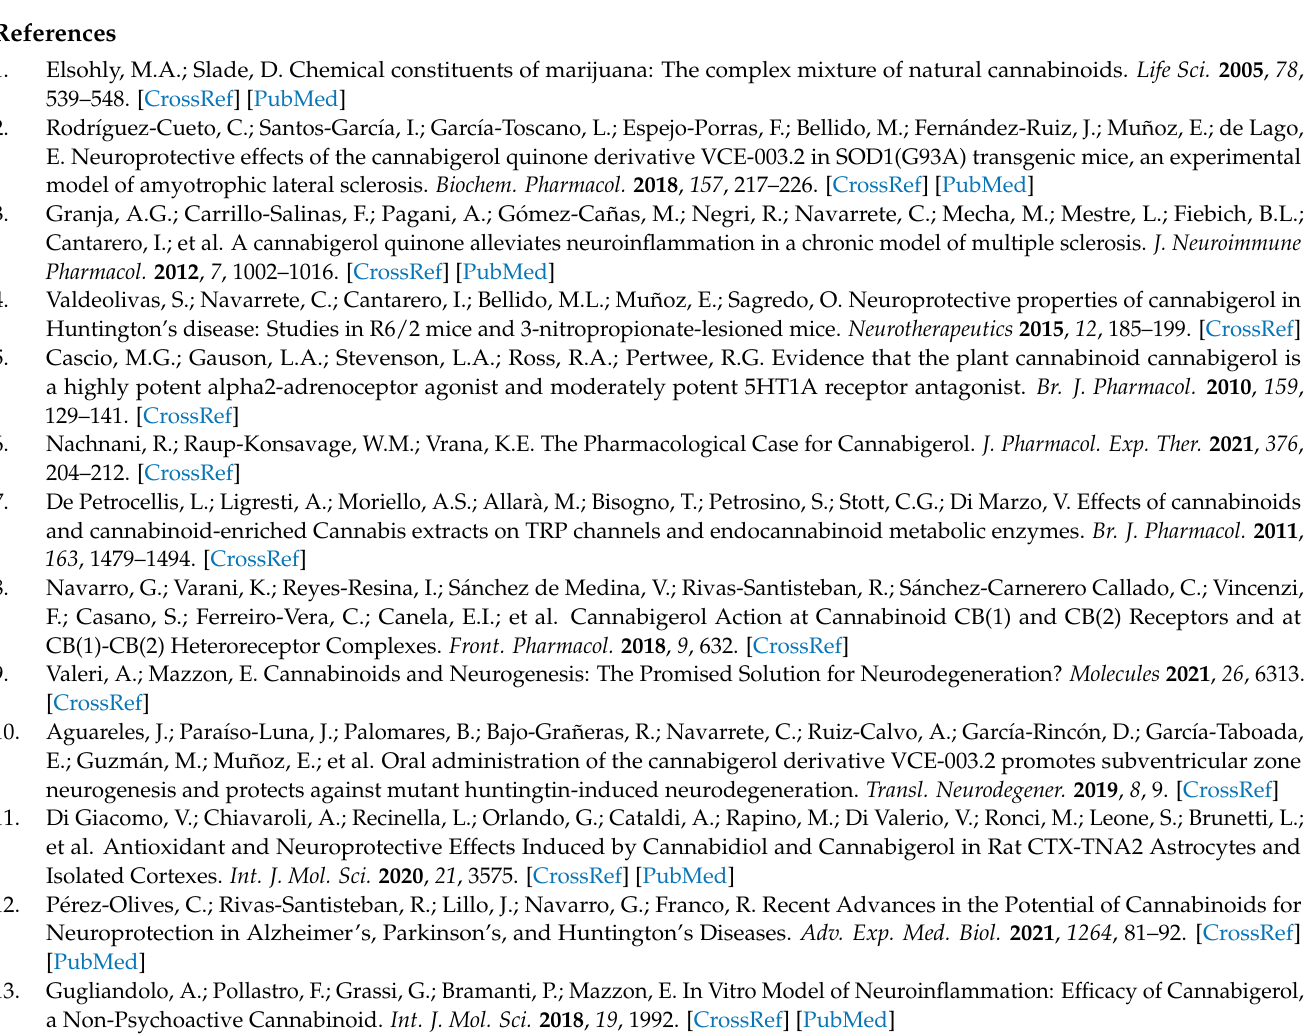
Figure S2: 1 H NMR of CBG in CDCl 3 400